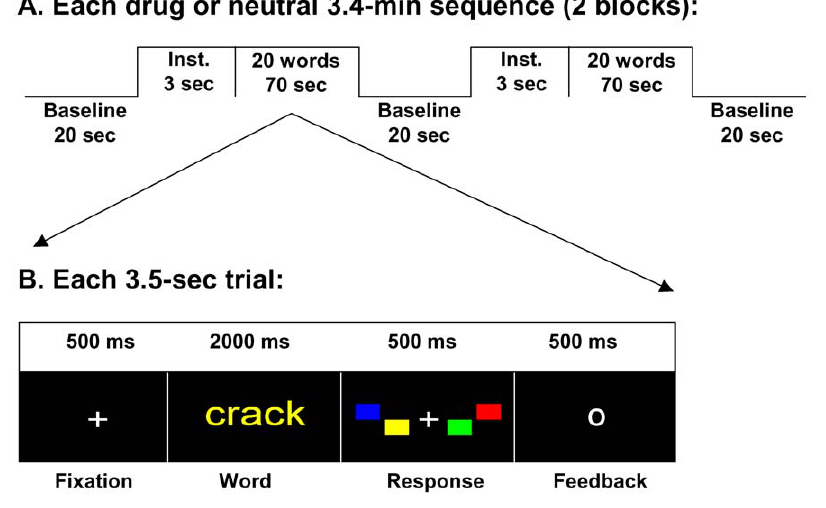
Figure 1. Drug-word fMRI paradigm. doi:10.1371/journal.pone.0010815.g001 PLoS ONE |